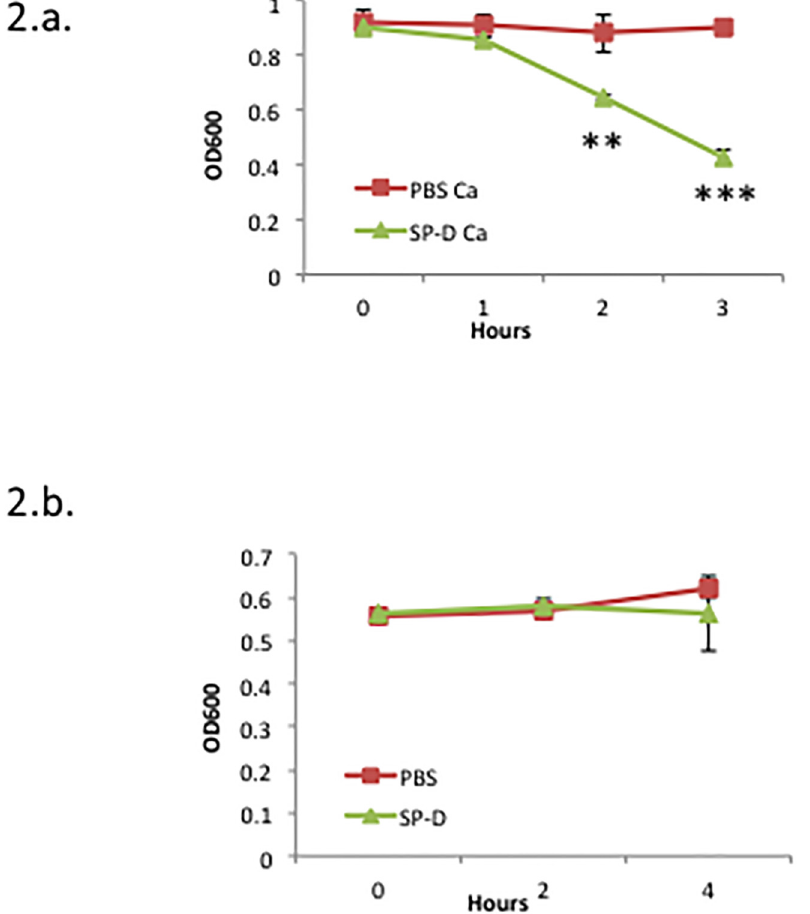
Fig 2. SP-D does not cause aggregation of C . burnetii . (A) E . coli or (B) C . burnetii were incubated with or without SP-D in PBS + CaCl 2 in an undisturbed suspension for 3 or 4 hrs, respectively. The ability of SP-D to aggregate the bacteria was determined using spectrometry readings at OD 600 . The data are representative of 3 independent experiments ± standard deviation. Student t-tests compare data sets +/- SP-D ** p < 0.005, *** p <